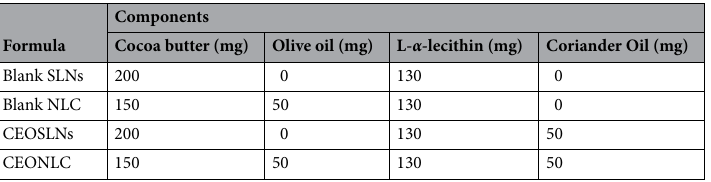
Table 3. Formulation components of the prepared